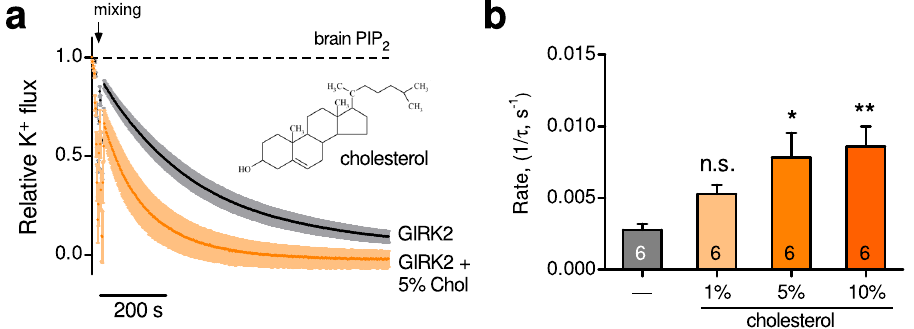
Figure 4. Cholesterol directly activates GIRK2 channels. ( a ) Normalized fluorescent traces (mean ± SEM) show K + flux for GIRK2-containing liposomes with 1% brain PIP 2 in the absence (black) or presence of 5% cholesterol (orange) (n = 6). Inset, chemical structure of cholesterol is shown. (b) Bar graph shows the increase in the rate of K + flux with different cholesterol concentrations (1%, 5%, and 10%). Statistical significance * p < 0.05, ** p < 0.01 (n =